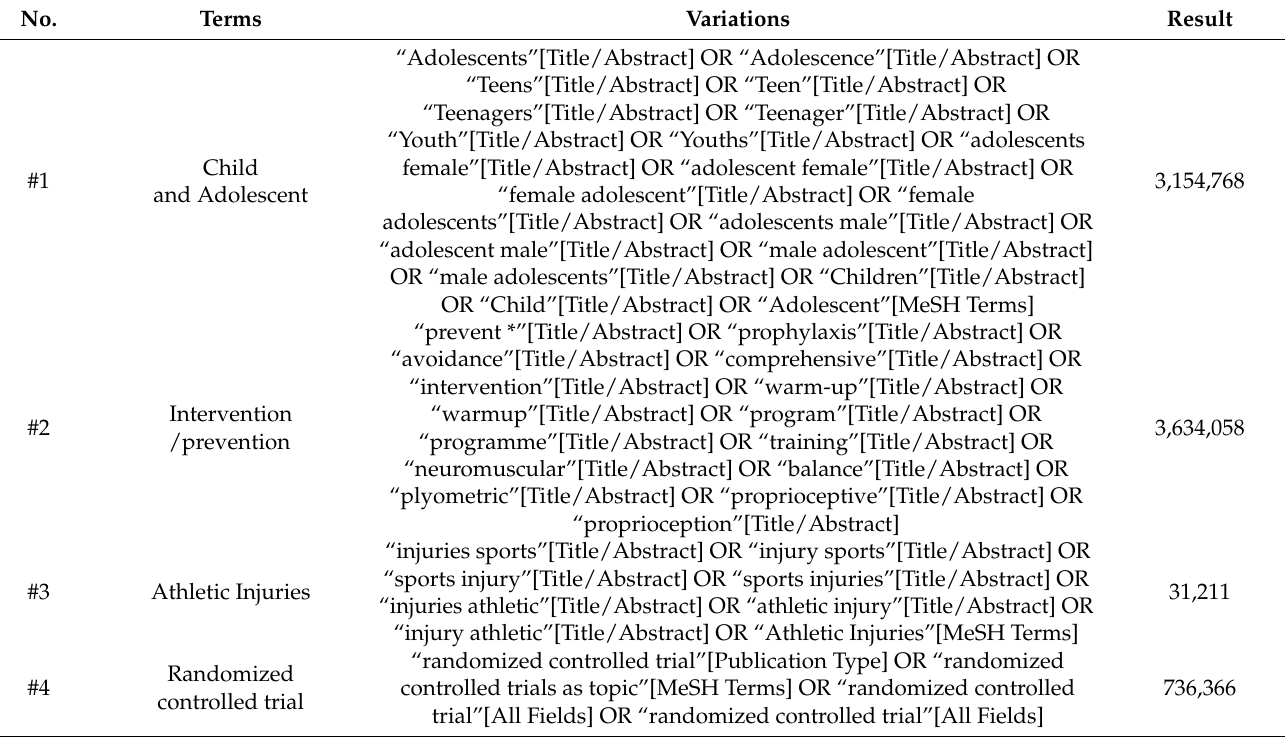
Table A2. Pubmed Search Terms and Variations Used for Systematic